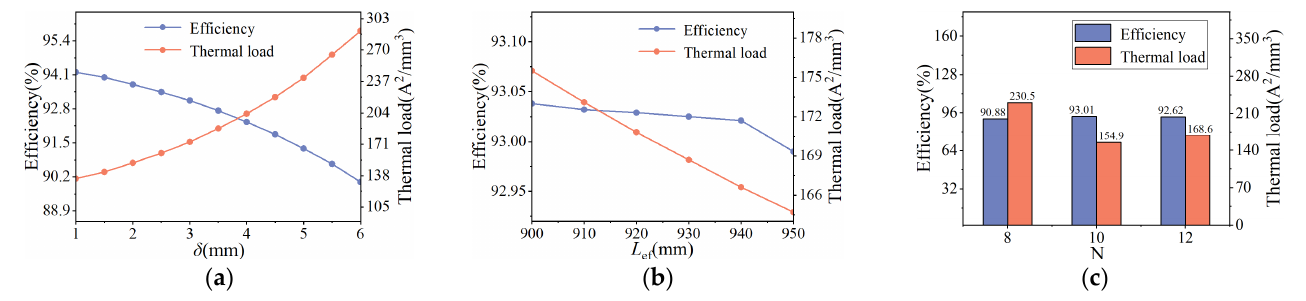
( c ) Figure 3. Influence curves of single factors on efficiency and thermal load. ( a ) Pole arc coefficient; ( b ) PM thickness; ( c ) stator outer diameter. The effect of the air gap length, core length and number of conductors per slot on the efficiency and thermal load are shown in Figure 4. In Figure 4a, with the gradual increase in the air gap length, the efficiency decreases and the thermal load increases, because the long air gap length reduces the air gap magnetic density and the loss increases accord ‐ ingly. At the same time, considering the assembly of the stator and rotor, the variation range of air gap length is set to 2–5 mm. Figure 4b shows the effect of the core length on the efficiency and thermal load. As the core length increases, both the efficiency and the thermal load decrease. However, when the core length is less than 940 mm, the efficiency decreases slightly with the increase in the core length, and when it is greater than 940 mm,